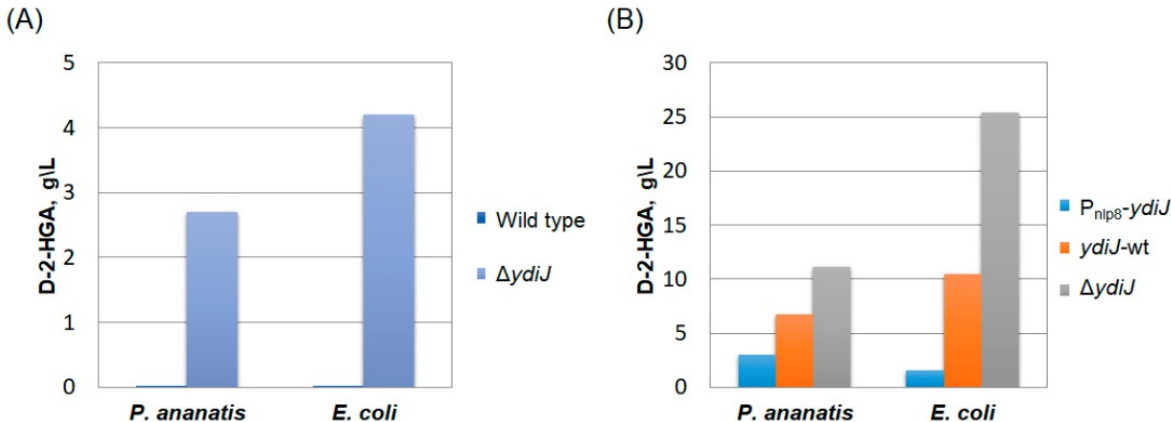
Figure 5. ( A ) D-2-HGA accumulation by E. coli MG1655 Δ ydiJ ::Km and P. ananatis SC17(0) Δ ydiJ ::Km. ( B ) D-2-HGA accumulation by P. ananatis SC17(0)/pMIV-P nlp8 - serA 348 and E. coli MG1655/pMIV-P nlp8 - serA 348 with various allelic stages of the ydiJ gene: enhanced expression of the ydiJ gene (P nlp8 - ydiJ ), expression of native ydiJ ( ydiJ -wt) and inactivation of ydiJ ( Δ ydiJ ).